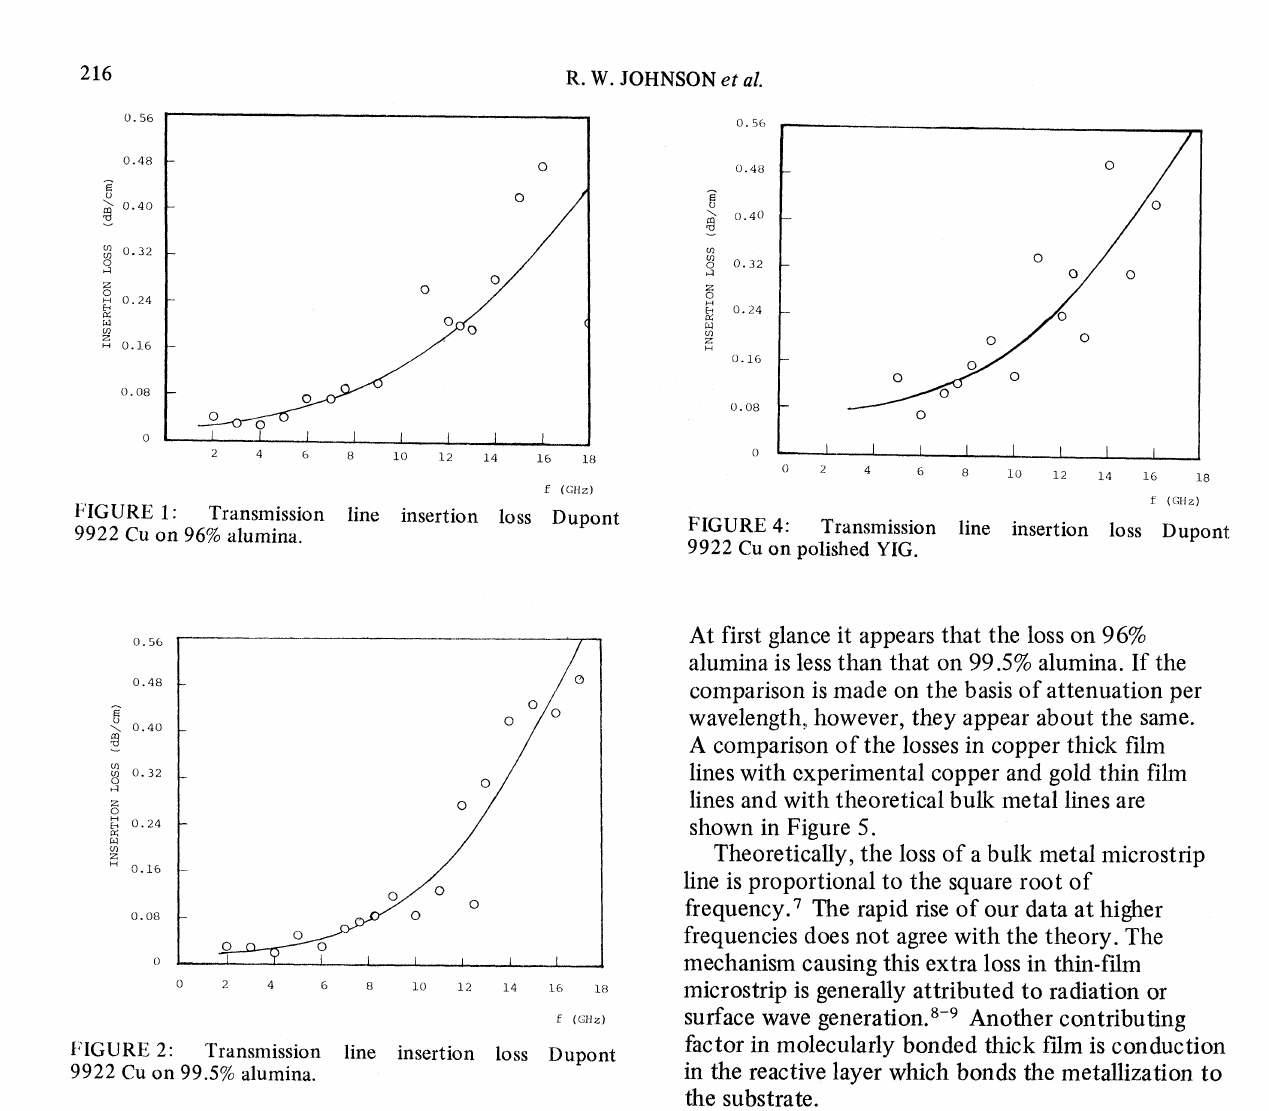
Transmission 9922 Cu on unpolished YIG,